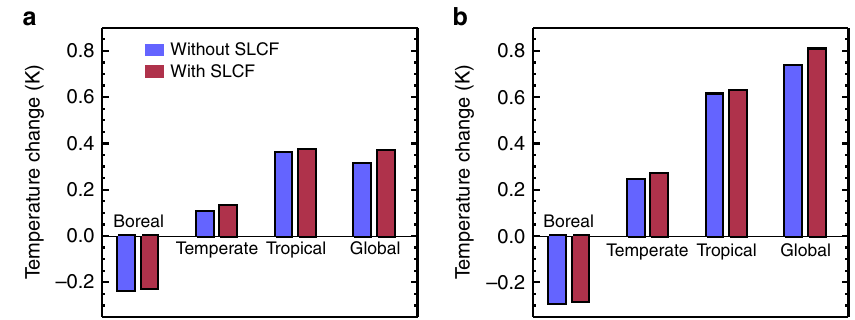
Fig. 3 Temperature changes due to deforestation. Net temperature changes after 20 years ( a ) and 100 years ( b ) for the global and regional deforestation scenarios, with and without the impacts of